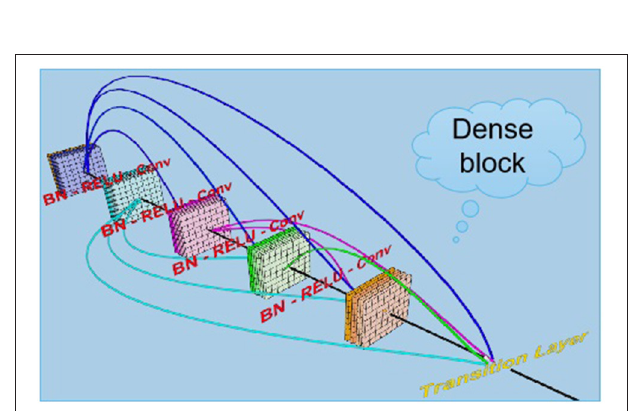
FIGURE 5 | Pooling process of deep learning